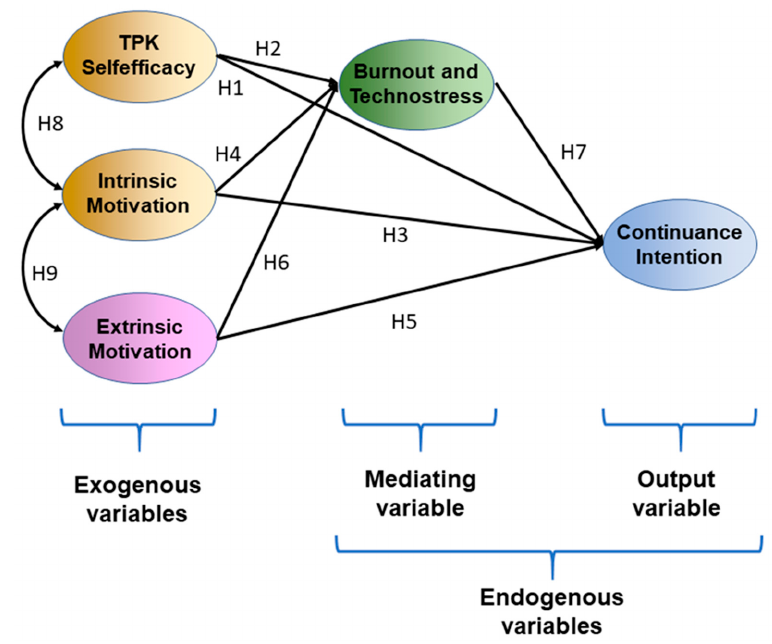
Figure 2. The research